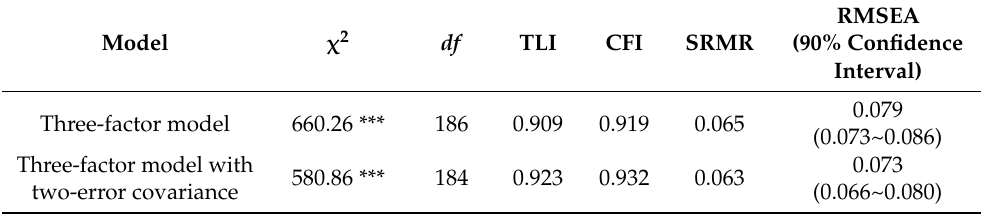
Table 2. Goodness of fit of confirmatory factor analyses for the